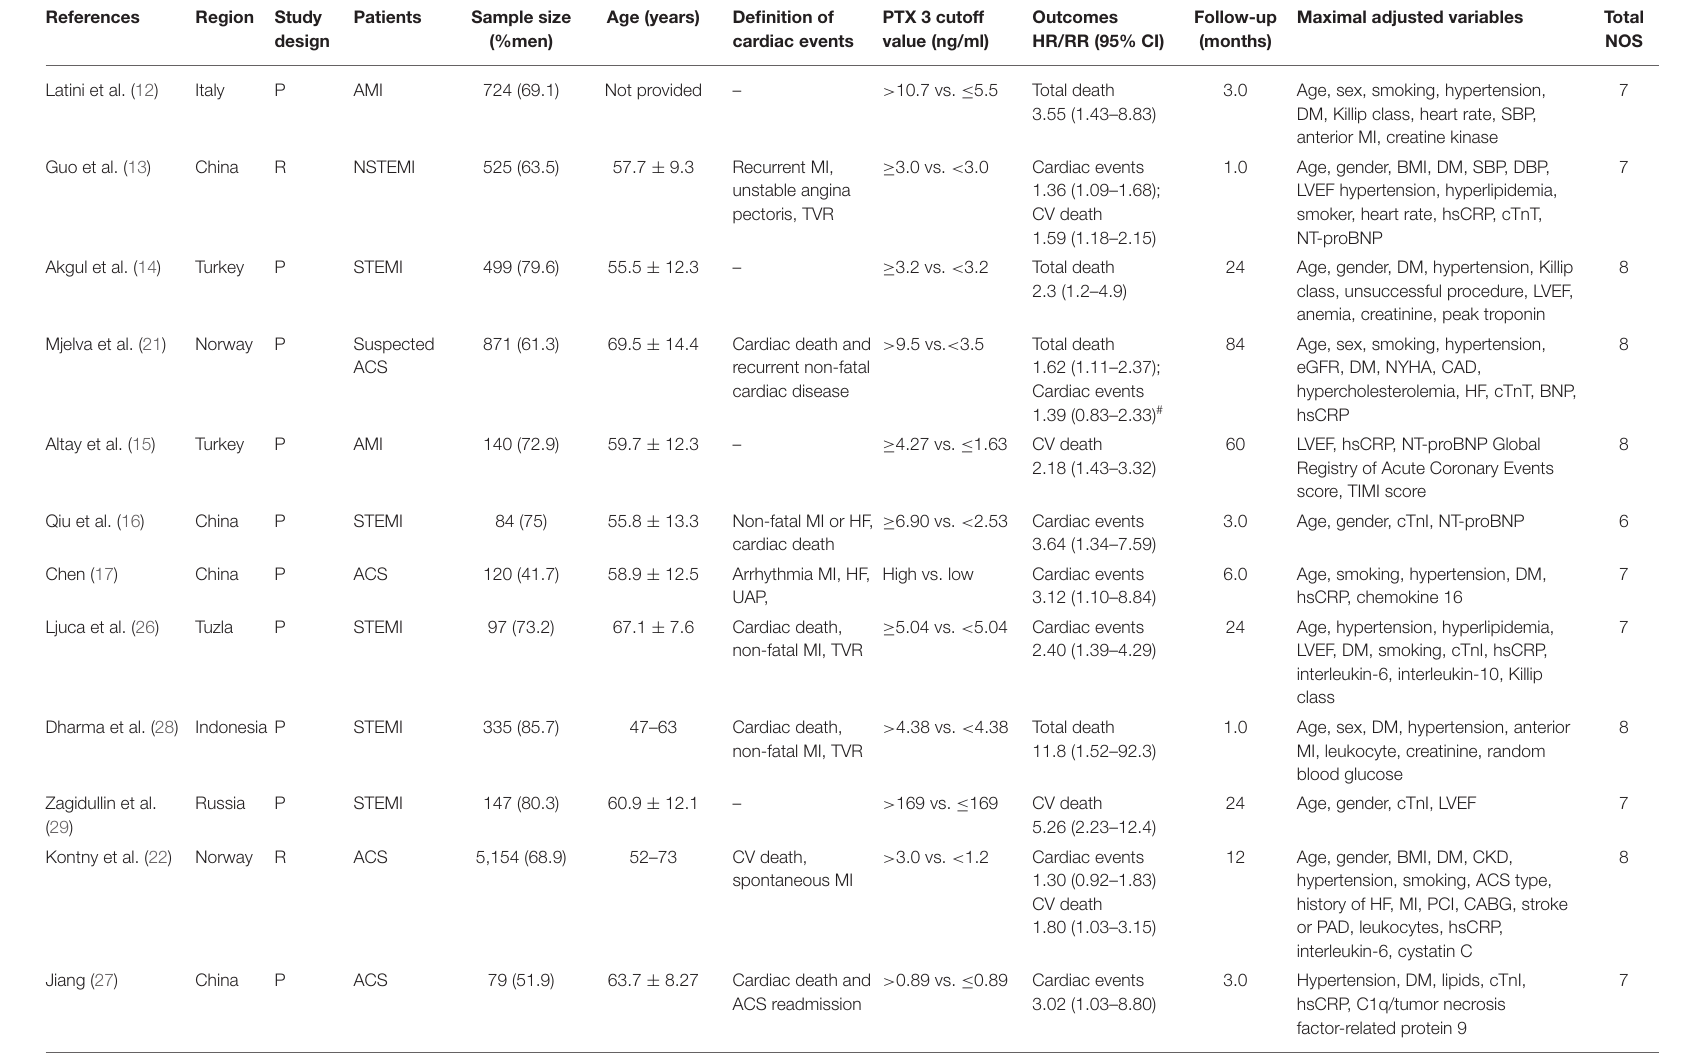
TABLE 1 | Characteristics of the included studies.